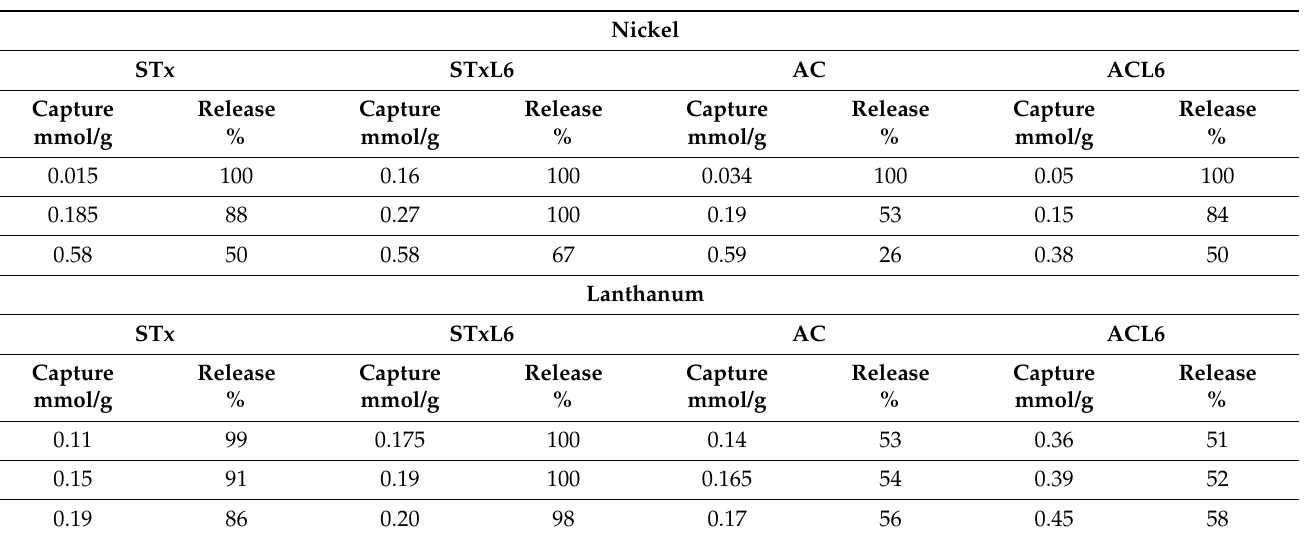
Table 4. Comparison of metal release percentages as a function of the absolute capture values for the four different sorbent solids.